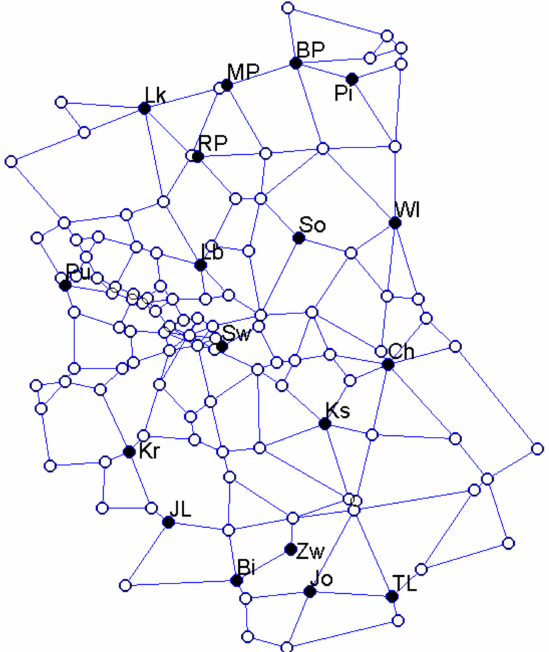
Figure 3. Graph presenting locations of pellets production and road